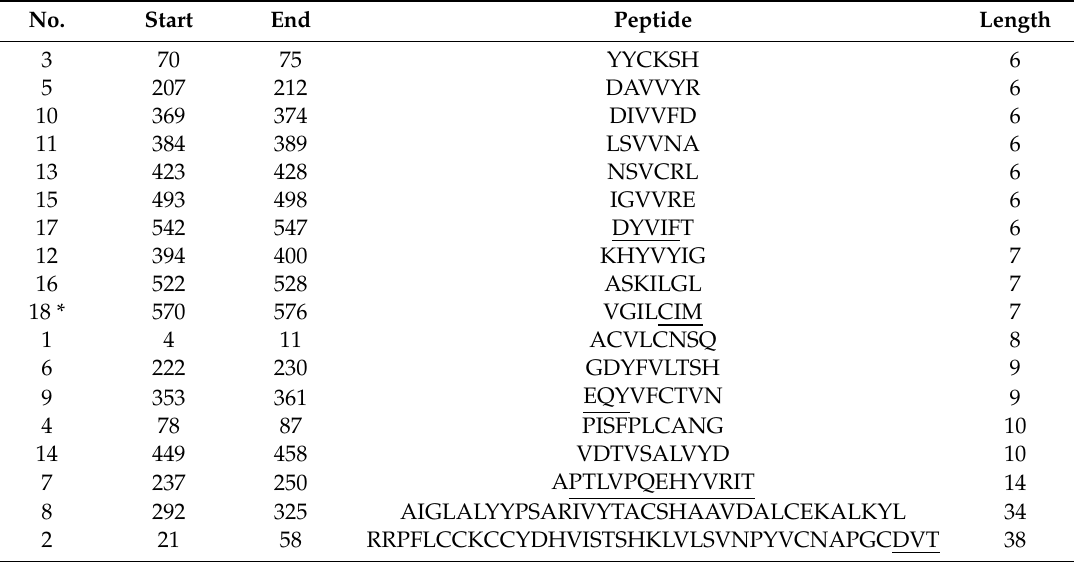
Table 3. Predicted antigenic B-cell epitopes of SARS-CoV-2 Nsp13 helicase protein.